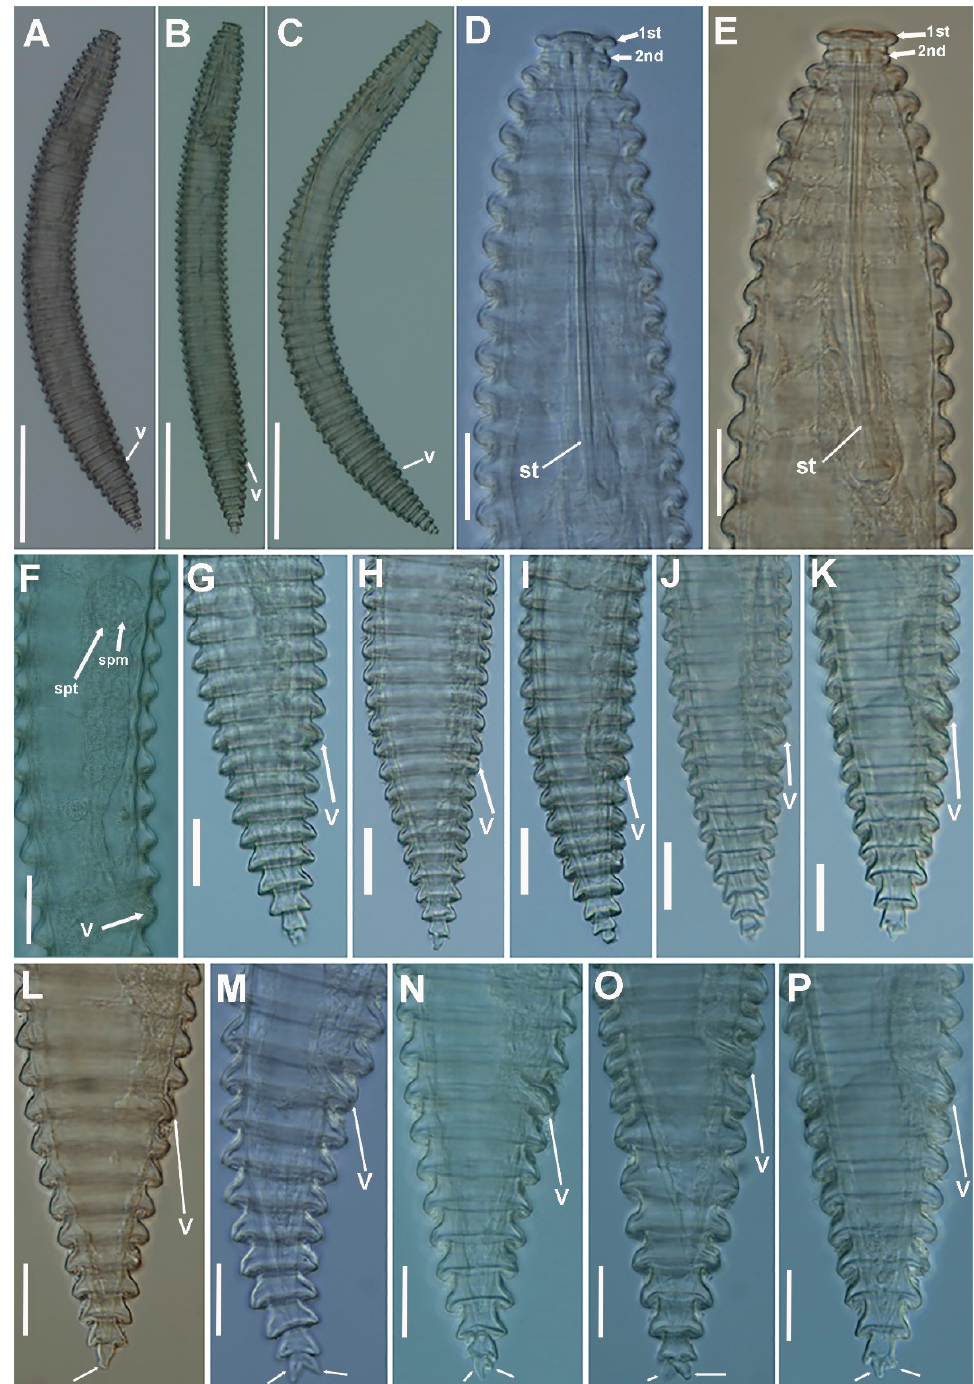
Figure 4. Light micrographs of Criconema paraannuliferum sp. nov. females. ( A – C ), whole female; ( D , E ), anterior region, 1st and 2nd body annuli (arrowed); ( F ), posterior region showing spermatheca filled with sperm (arrowed); ( G – P ), posterior region showing vulva (arrowed). Abbreviations: spt = spermatheca, spm = sperm; st = stylet; V = vulva; 1st, 2nd = first- and second-body annuli. Scale bars: 20 µm.